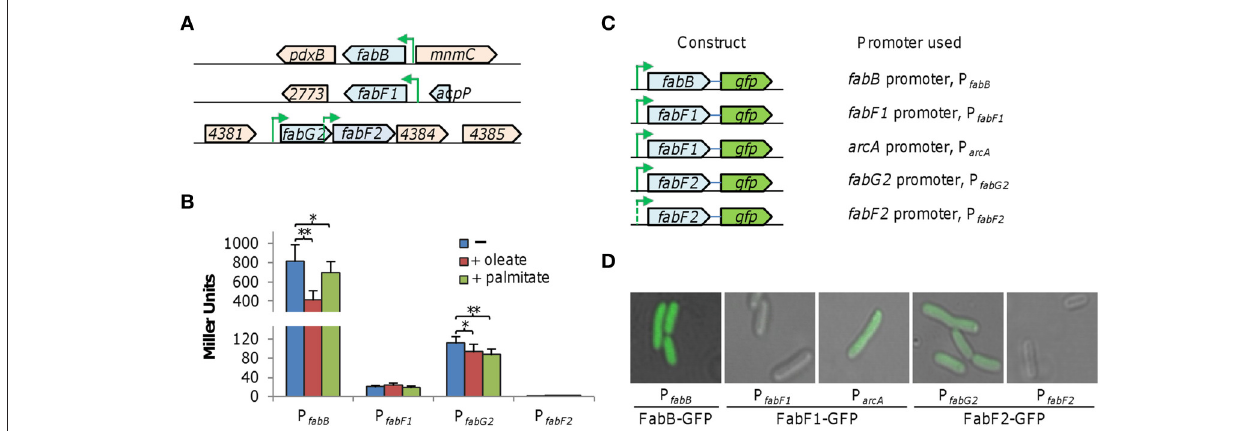
FIGURE 2 | Expression of fabB , fabF1 , and fabF2 in S. oneidensis. (A) Organization of the S. oneidensis fabB , fabF1 , and fabF2 gene regions. Operon structures are referred to multiple databases (biocyc.org; microbesonline.org). Predicted promoters P fabB , P fabF1 , P fabG2 , and P fabF2 , are shown with arrows. Genes are drawn to scale. (B) Influence of 0.005% oleate (C18:1 1 9) and palmitate (C16:0) on activities of the predicted promoters. Predicted promoters shown in (A) were cloned into an integrative lacZ reporter and their activity in mid-log phase cells was assayed as described in Methods. Both fabB and fabF2 are responsive to fatty acid additions based on their promoter activities. Error bars represents standard deviation (SD) from at least three independent experiments. Asterisks, statistically significant difference ( * p < 0.01; ** p < 0.001; n ≥ 3). (C) Constructs for GFP fusions produced under the control of indicated promoters. The gfp gene was placed after each gene under test and a short linker was added in between to ensure function of GFP. Each of these constructs within the same vector was introduced the wild-type. (D) Visualization of GFP fusions from constructs described in (D) . Activity of P fabF1 is very low. Results shown are representative of three independent